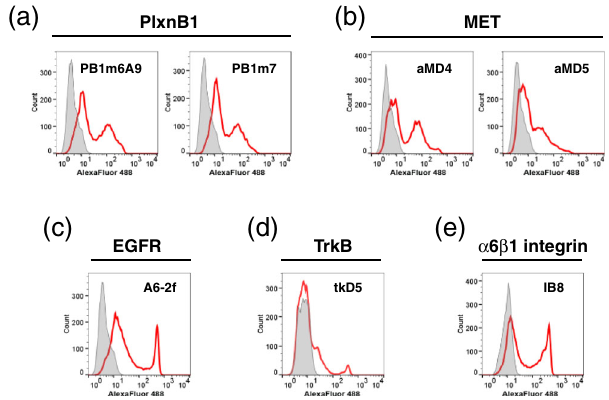
Fig. 4 FACS analysis of peptide-grafted Fc protein binding to cell surface target receptors. HEK293T cells transiently expressing PlxnB1 ( a ), MET ( b ), EGFR ( c ), TrkB ( d ), or α 6 β 1 integrin ( e ) are incubated with each peptide-grafted Fc (red histogram) or control Fc (gray histogram), followed by labeling with Alexa Fluor 488-labeled anti-human Fc.